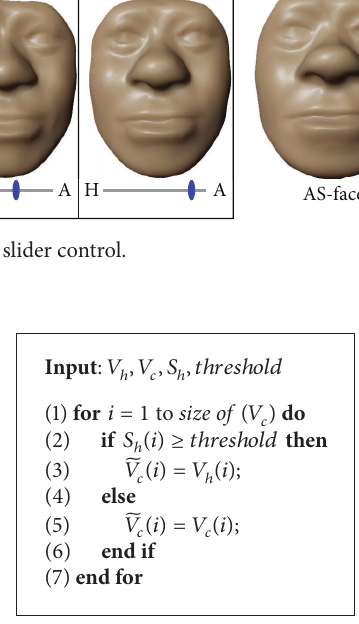
Algorithm 1: Identity engineering algorithm.